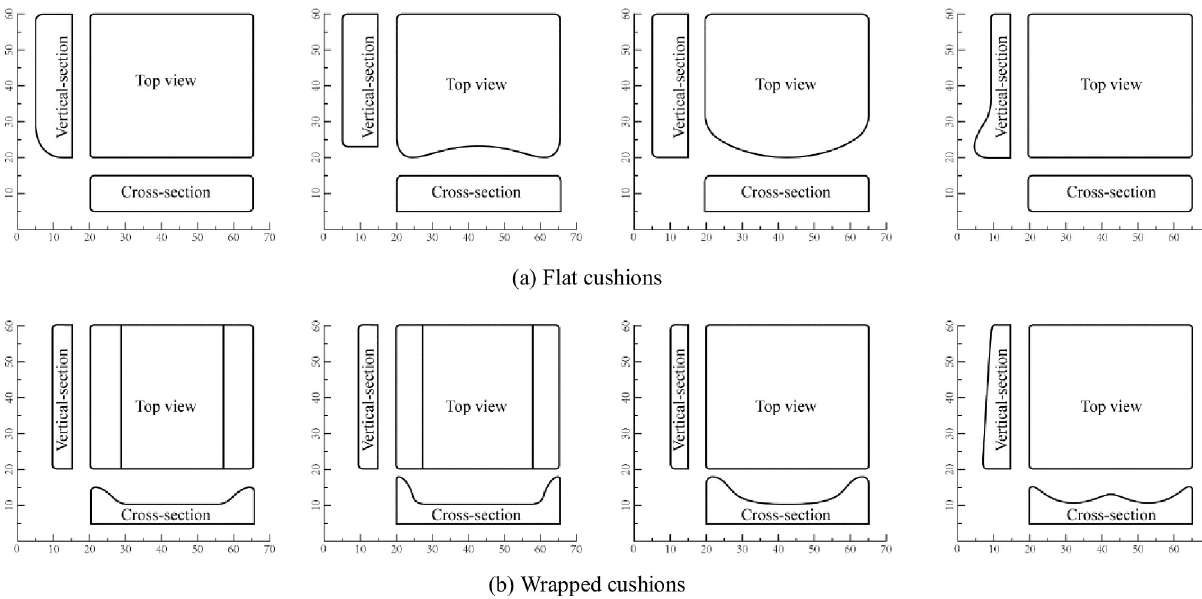
Fig 4. Three views of eight cushion geometry designs (unit: Cm). (a) Flat cushions and (b) Wrapped cushions.